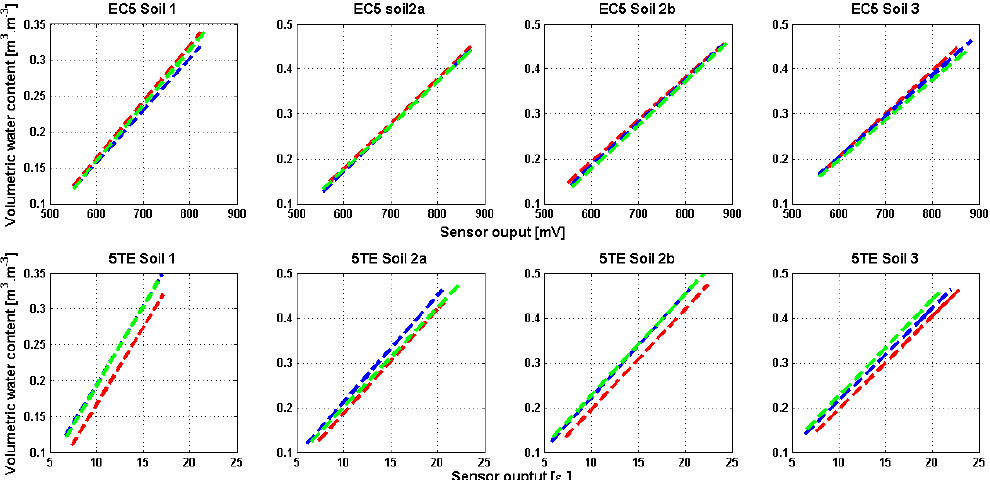
Figure 5. Linear regression equations obtained of the standard calibration method results, for the EC5 and 5TE sensor and for soils 1,2a, 2b and